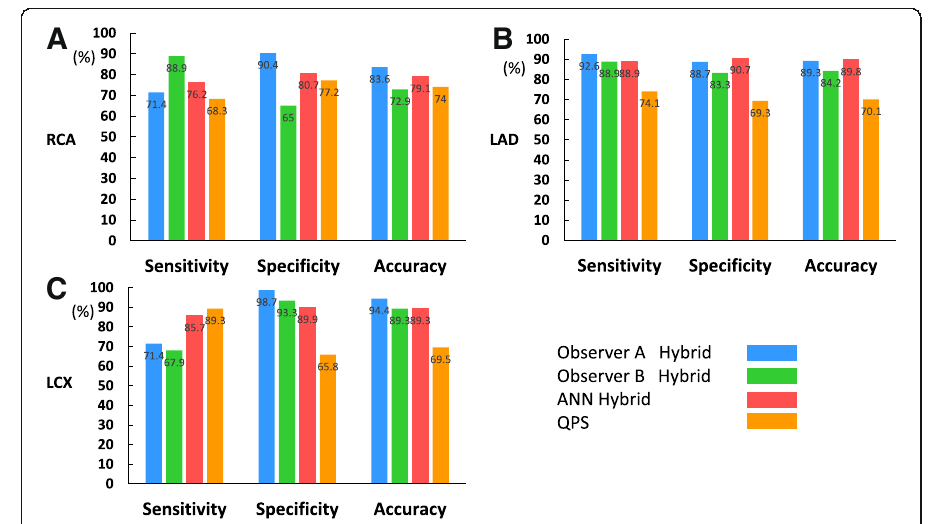
Fig. 3 Sensitivity, specificity, and accuracy of CAD detection in RCA ( a ), LAD ( b ), and LCX ( c ), by ANN, QPS, and two observers with hybrid images. ANN artificial neural network, CAD coronary artery disease, LAD left anterior descending coronary artery, LCX left circumflex coronary artery, QPS quantitative perfusion single-photon emission computed tomography (SPECT), RCA right coronary